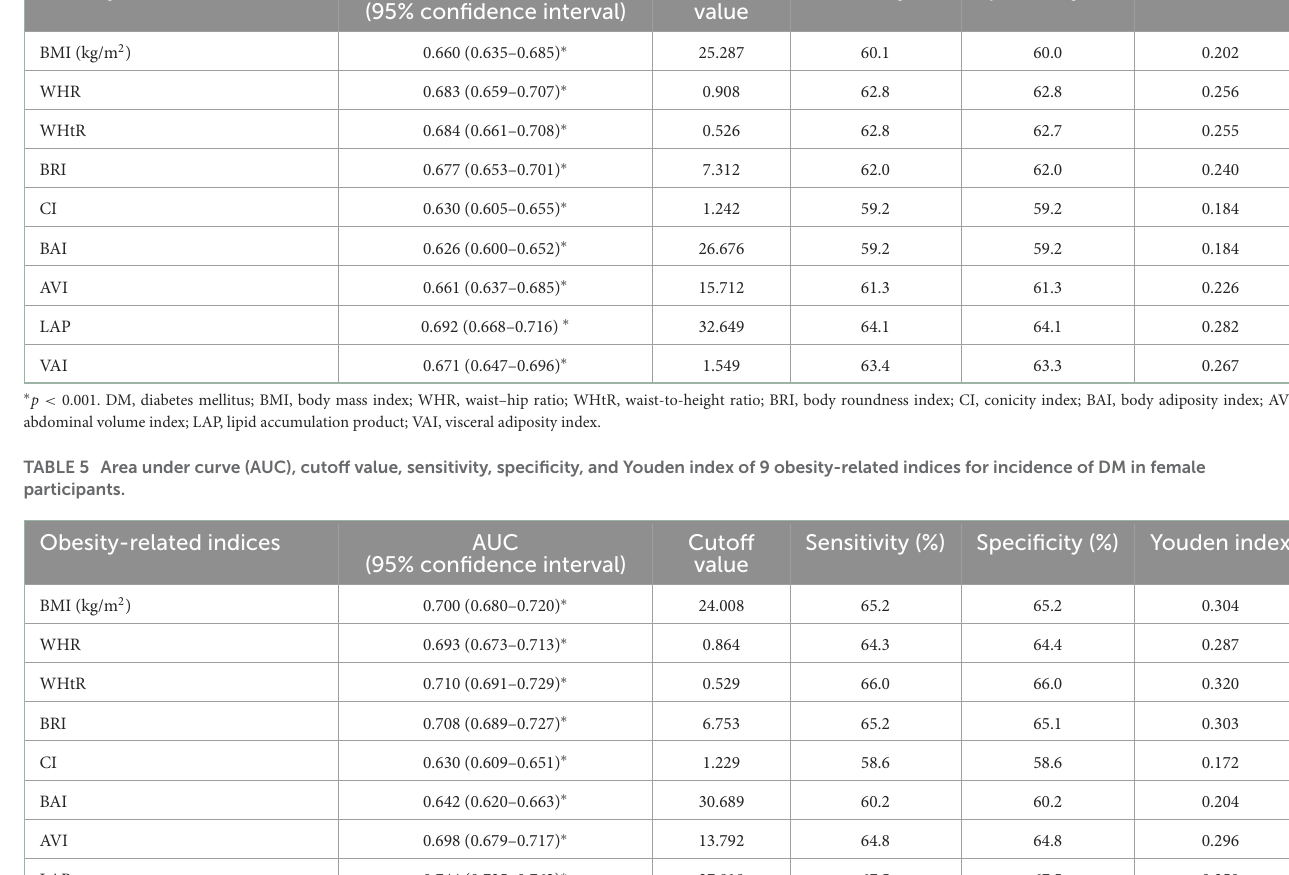
TABLE 4 Area under curve (AUC), cutoff value, sensitivity, specificity, and Youden index of 9 obesity-related indices for incidence of DM in male participants. Obesity-related indices